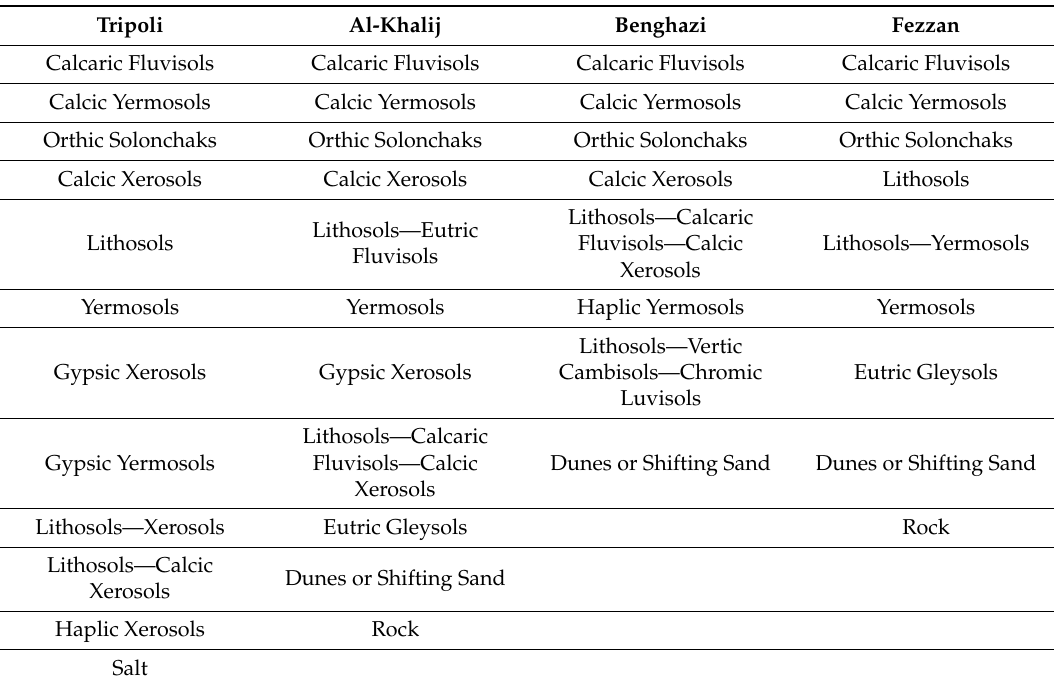
Figure 2. Soil map of Libya (adapted from [13]). Table 3. Soils of Libyan territories based on the Food and Agriculture Organization (FAO) of the United Nations (UN) soil classification system [13].